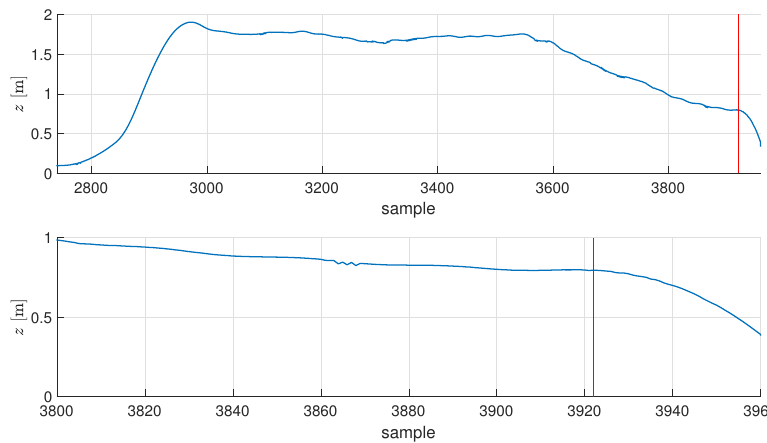
Figure 4. Marking of a sample terminating an experiment.